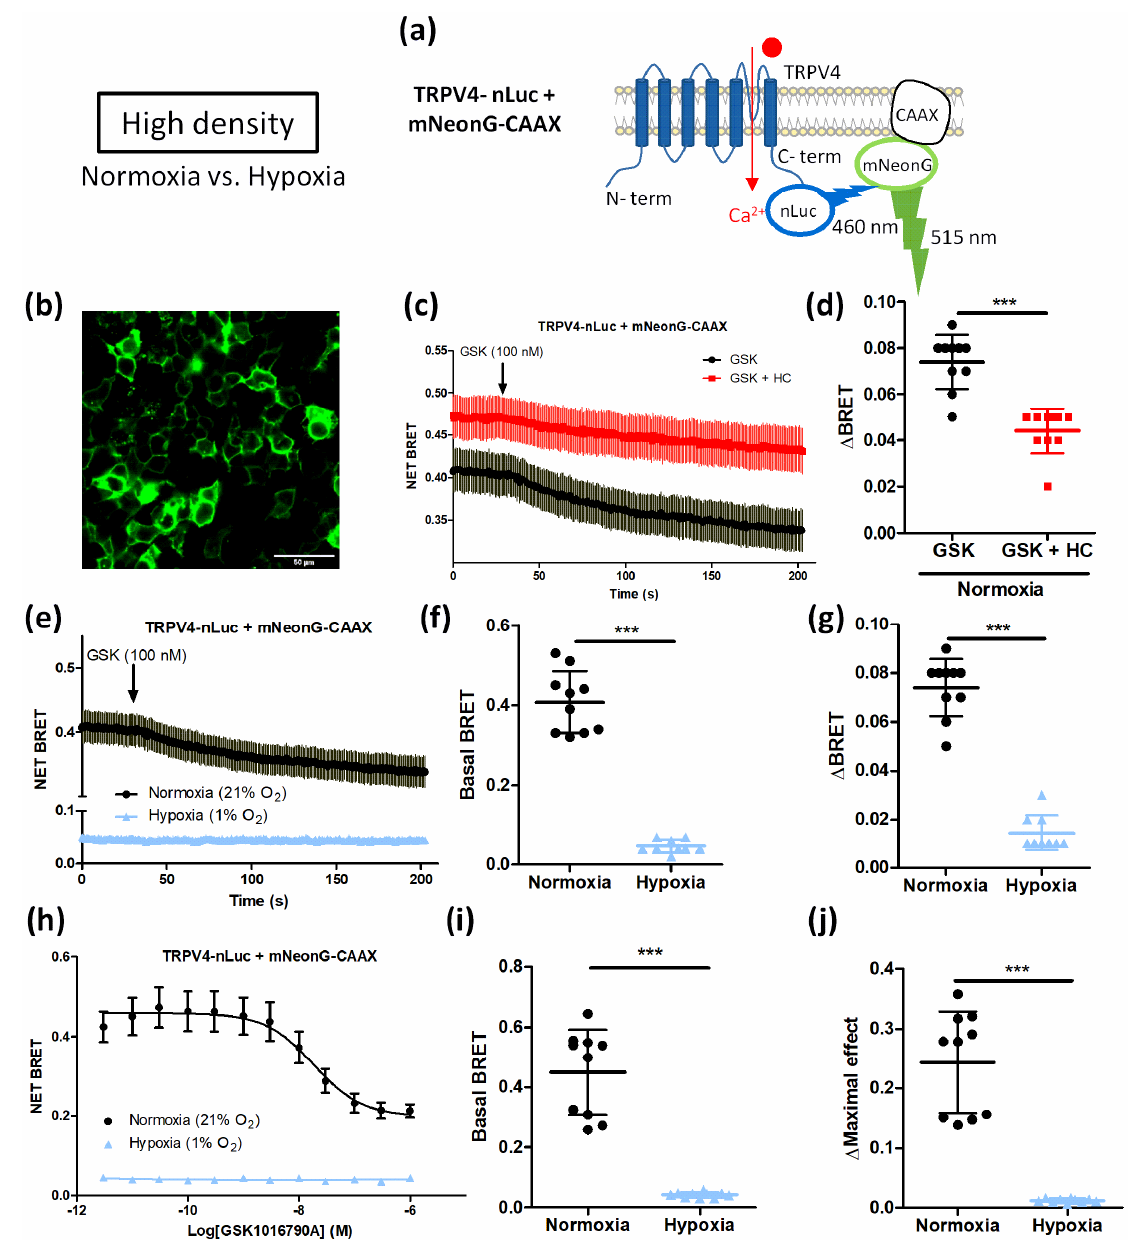
Figure 8. Hypoxia impairs agonist-induced TRPV4 internalization in transiently TRPV4-transfected HEK293T cells cultured at high density. ( a ) Schematic representation of TRPV4-nLuc and mNeonG-CAAX. ( b ) Representative confocal fields of mNeonG-CAAX transfected HEK293T cells (scale bar = 50 µm). ( c ) Kinetic BRET measurement of the effect of GSK1016790A (100 nM) on cells transfected with mNeonG-CAAX and TRPV4-nLuc BRET probes in presence or absence of HC067047 (1 µM) and cultured at high cell confluence (3 × 10 5 cells/cm 2 ) under normoxia, and ( d ) maximal absolute amplitude (ΔBRET). ( e ) Kinetic BRET measurement of the effect of GSK1016790A (100 nM) on HEK293T cells transfected with mNeonG-CAAX and TRPV4-nLuc BRET probes and cultured under normoxia (21% O 2 ) or hypoxia (1% O 2 ) for 48 h, ( f ) basal BRET, and ( g ) maximal absolute amplitude (ΔBRET). ( h ) Concentration– response curves of the effect of GSK1016790A on HEK293T cells transfected with mNeonG-CAAX and TRPV4-nLuc BRET probes and cultured under normoxia or hypoxia, ( i ) basal BRET, and ( j ) maximal concentration–response curve